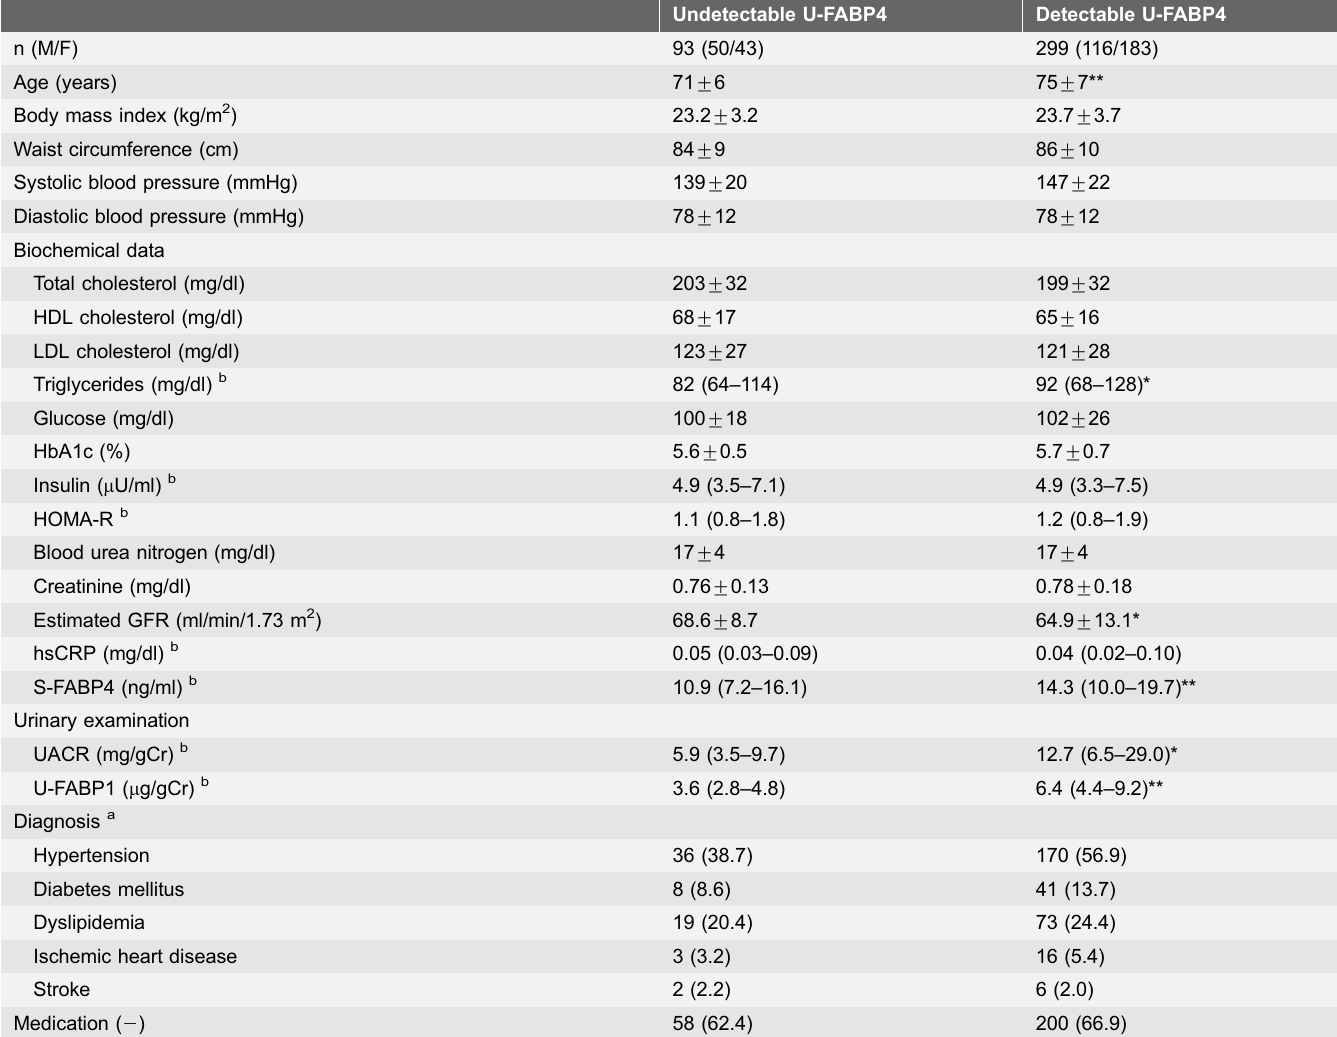
Table 2. Characteristics of the subjects with and without detectable